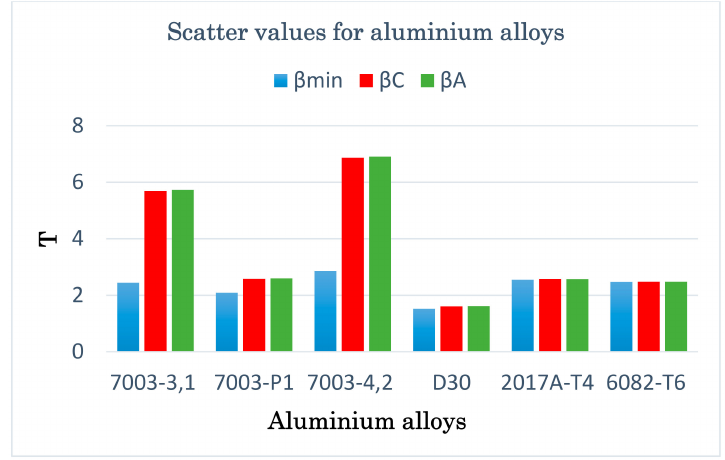
Figure 14. Scatter values for the design models used in the case of aluminium alloys.